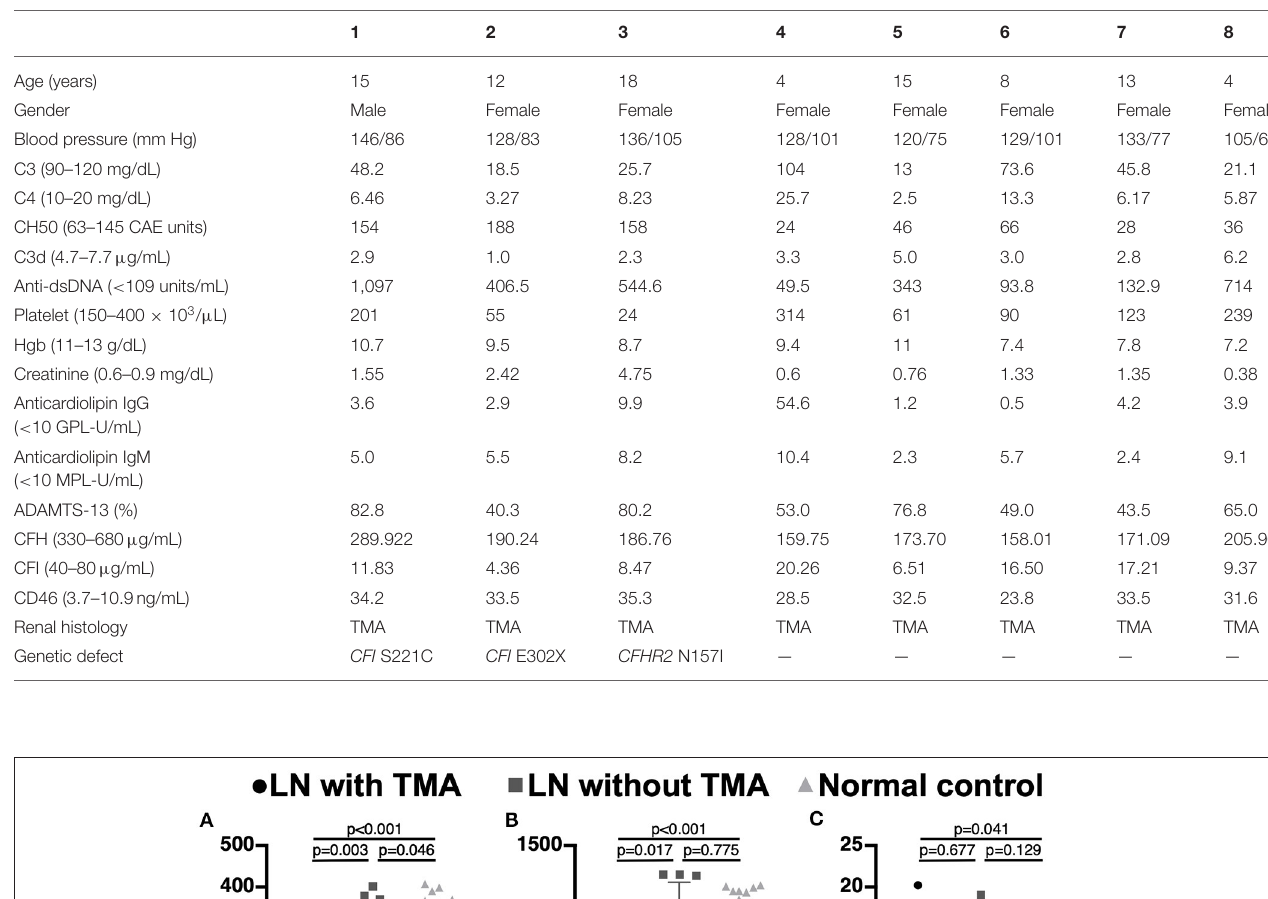
TABLE 2 | Clinical, laboratory, and histological features of individual with lupus nephritis and concomitant thrombotic microangiopathy.